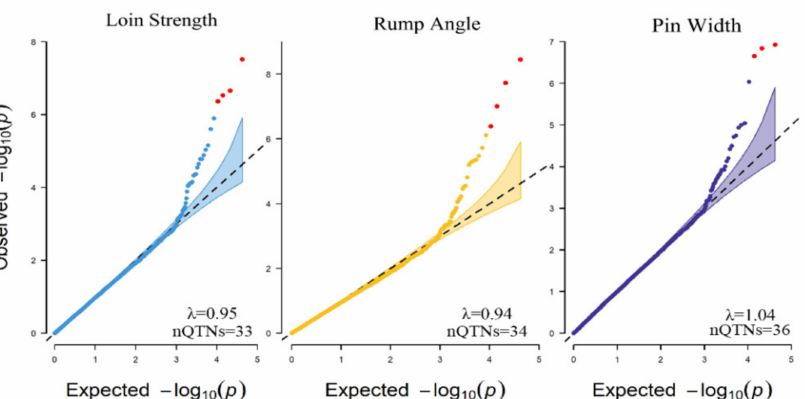
Figure 5. Quantile–quantile (QQ) plots of the three traits drawn by the expected p -Value (the uniformly distributed quantile from 0 to 1) and observed p -Value of each SNP. The red dots are SNPs that exceeded the threshold; the shaded parts are the confidence intervals. λ : genomic inflation factor; nQTNs: number of pseudo-QTNs in the